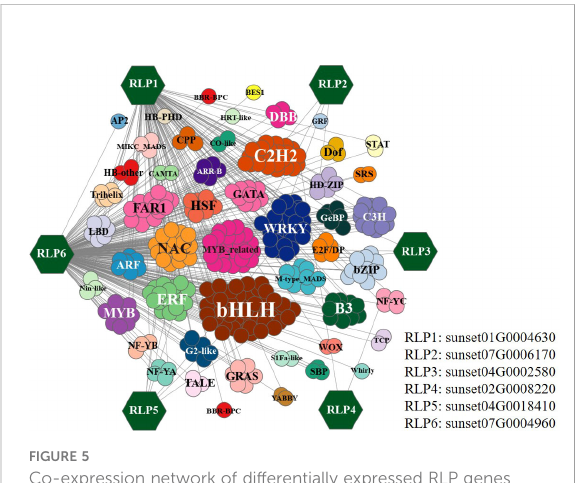
FIGURE 5 Co-expression network of differentially expressed RLP genes with the involved transcription factors. The colour- fi lled hexagons represent the RLP genes. Correlations between TFs and RLP genes were calculated using a Pearson ’ s correlation test (P ≤ 1e –